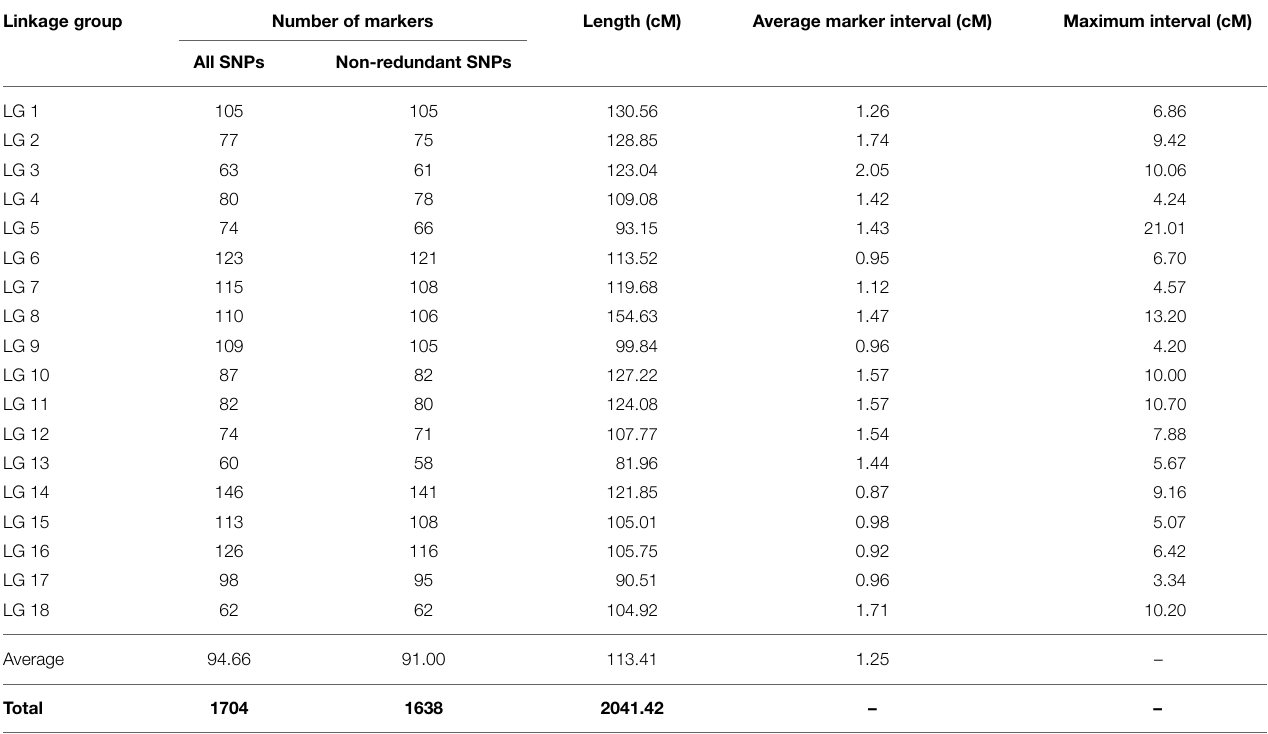
TABLE 2 | Distribution of SNP markers on the linkage map derived from population P (BPM24 × RRIM600). Linkage group Number of markers Length (cM) Average marker interval